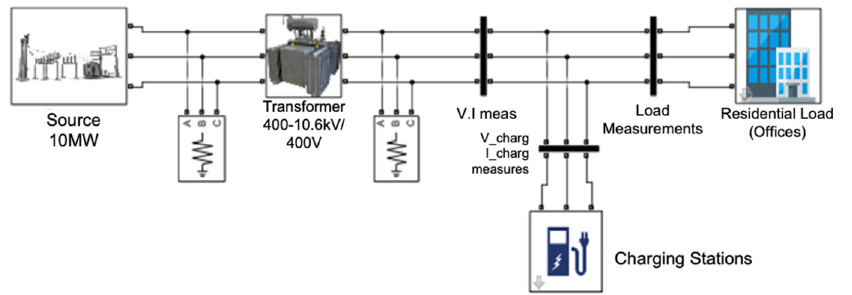
Figure 9. Scheme of the general view of the simulated system.